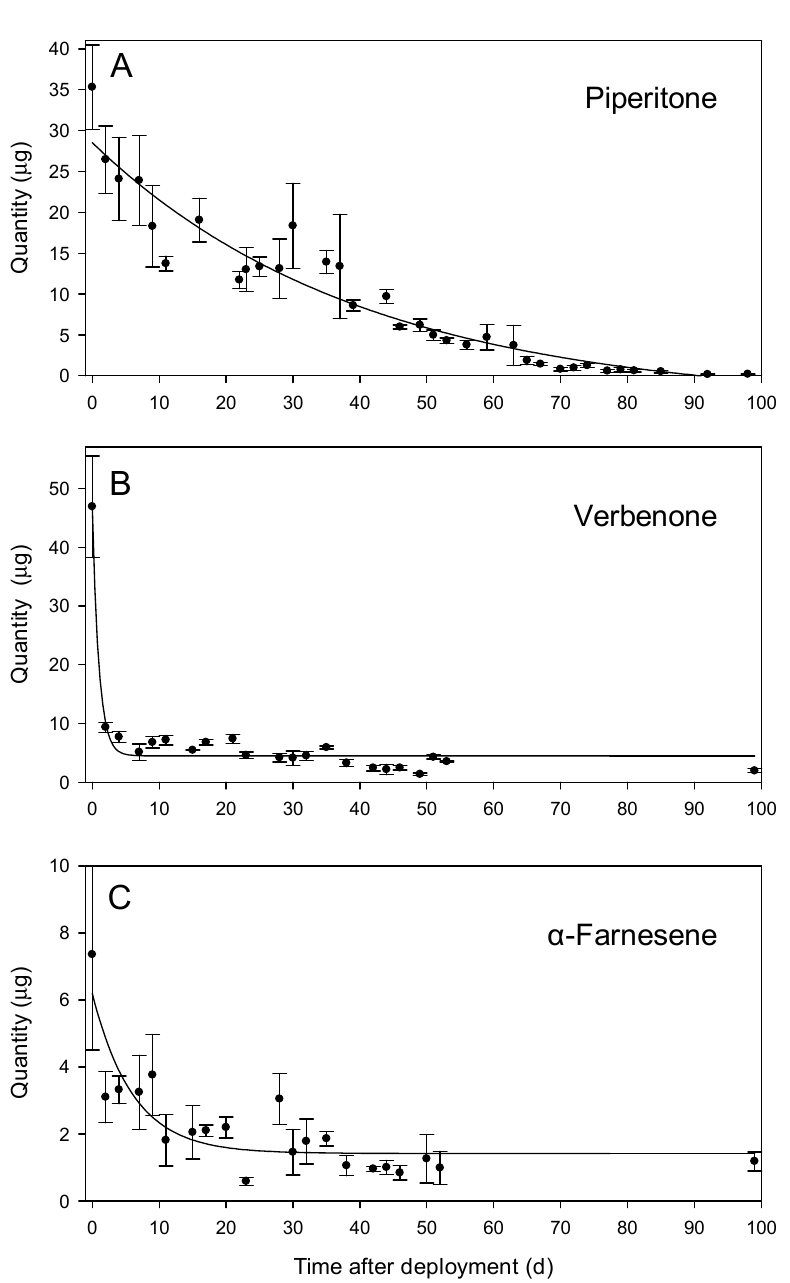
Figure 6. Mean volatile emissions quantified from bubble dispensers containing ( A ) piperitone, ( B ) verbenone, and ( C ) α -farnesene. All dispensers were aged in the field for 99 days and periodically brought into the laboratory for volatile collections and analysis by GC-FID and GC-MS.